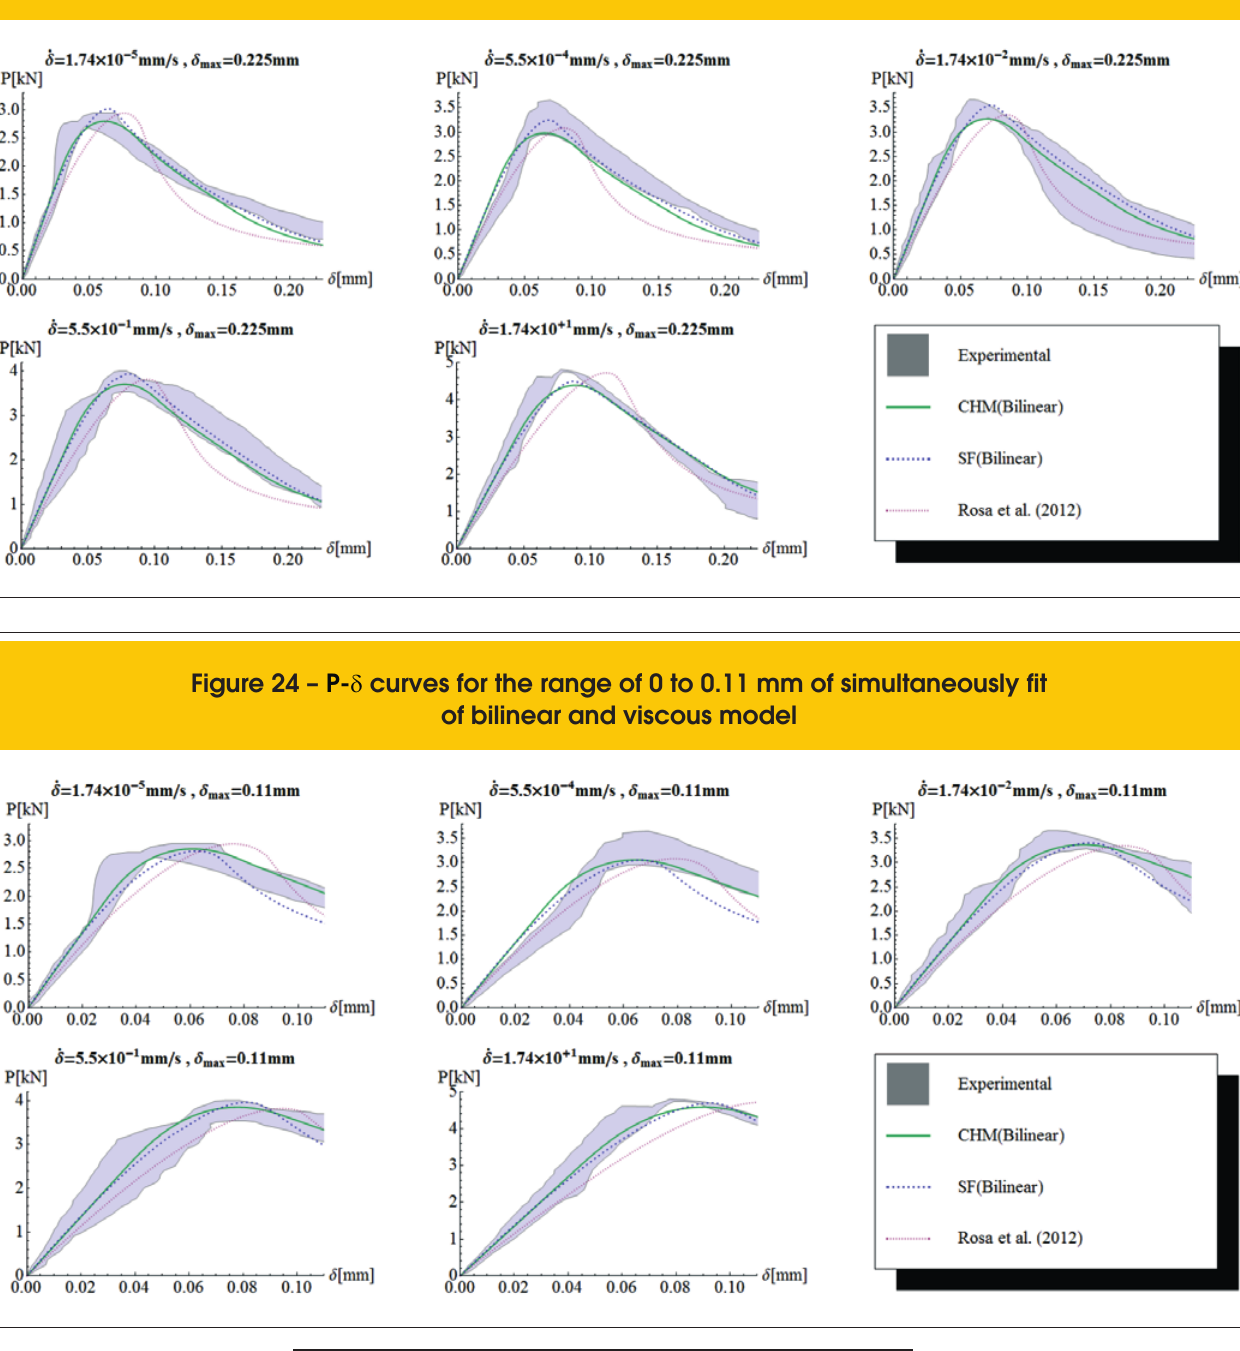
Table 10 – Adjusting [33] cohesive curves using